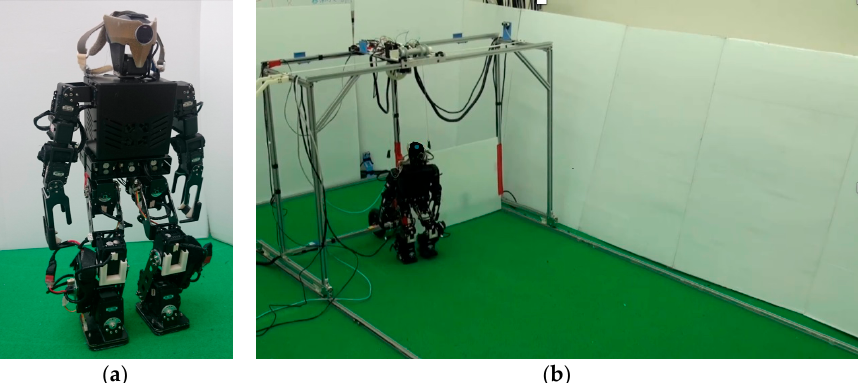
Figure 1. Experimental platforms: ( a ) small-sized humanoid robot; ( b ) automatic training platform.